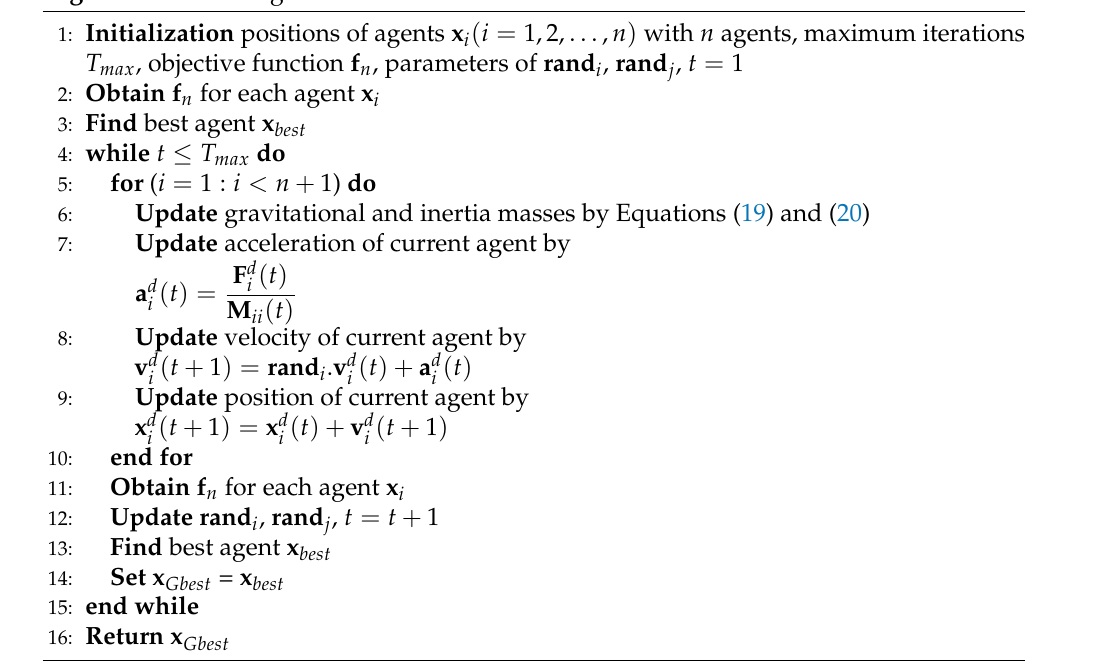
Algorithm 2 GSA